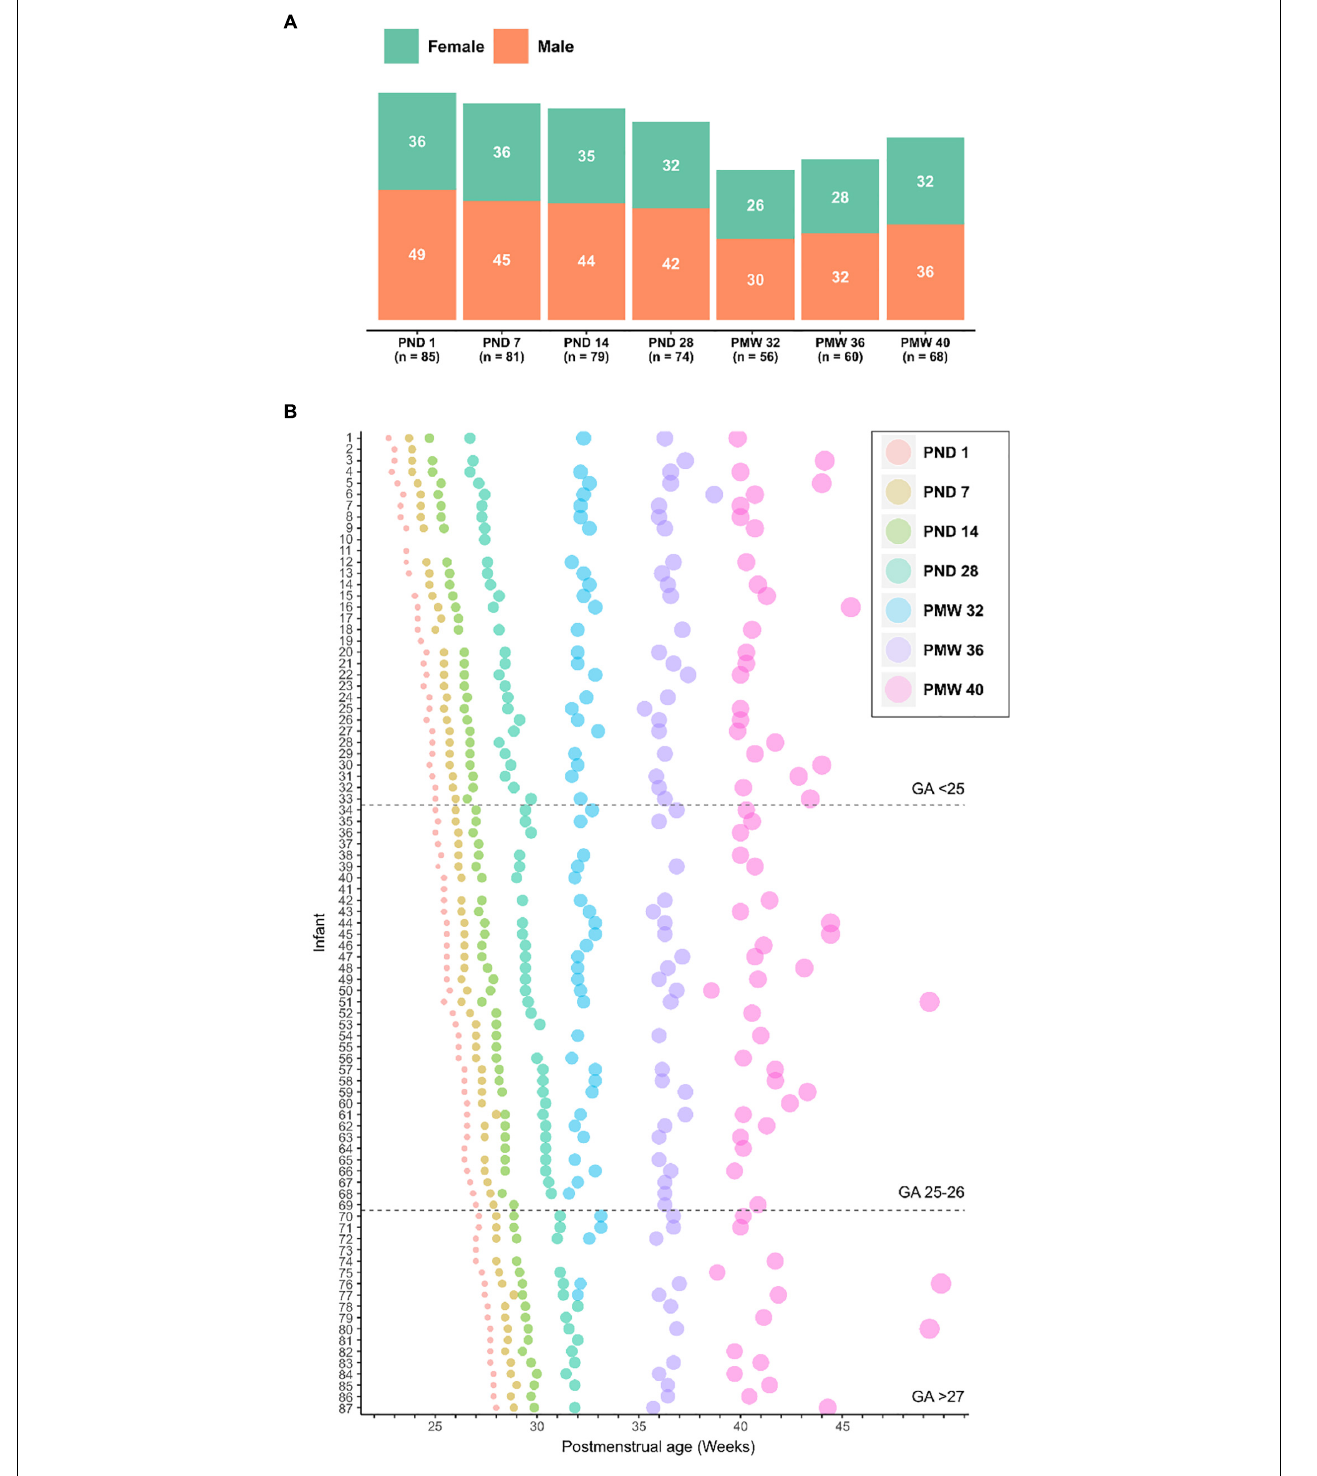
FIGURE 1 | Overview of analyzed samples. (A) Number of samples collected at seven time points used for serum metabolomics presented by gender. (B) Longitudinal serum sampling scheme for all infants included in the study. Infants are sorted by gestational age at birth. The size of the dot at sampling is proportional to the postnatal age of the infant and the color indicates the sampling time point accordingly to legend. GA, gestational age; PND, postnatal day; PMW, postmenstrual week.